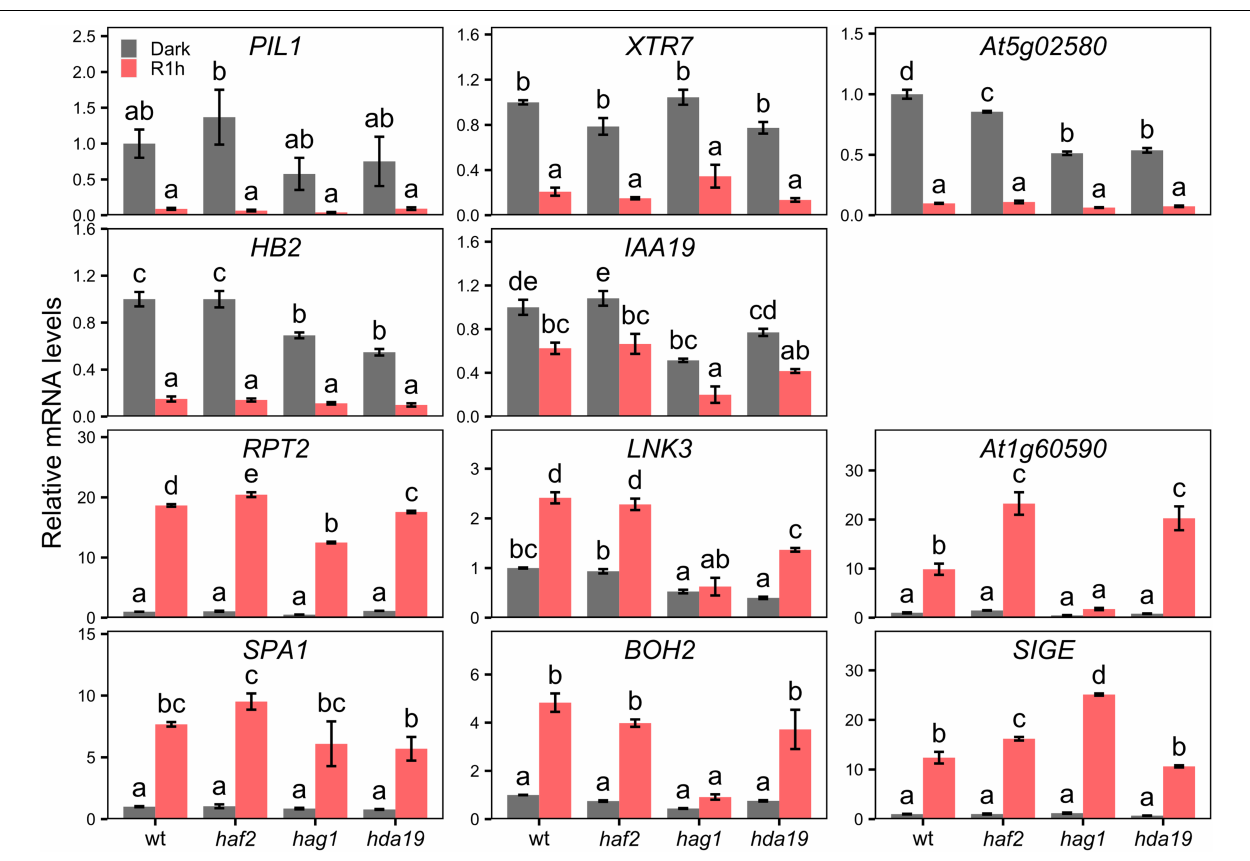
involved in H3K9ac regulation and previously identified to